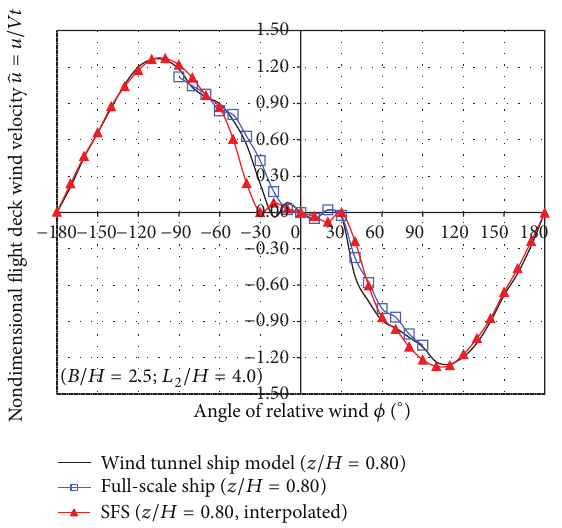
Figure15:Comparisonofthelongitudinalnondimensionalvelocity.